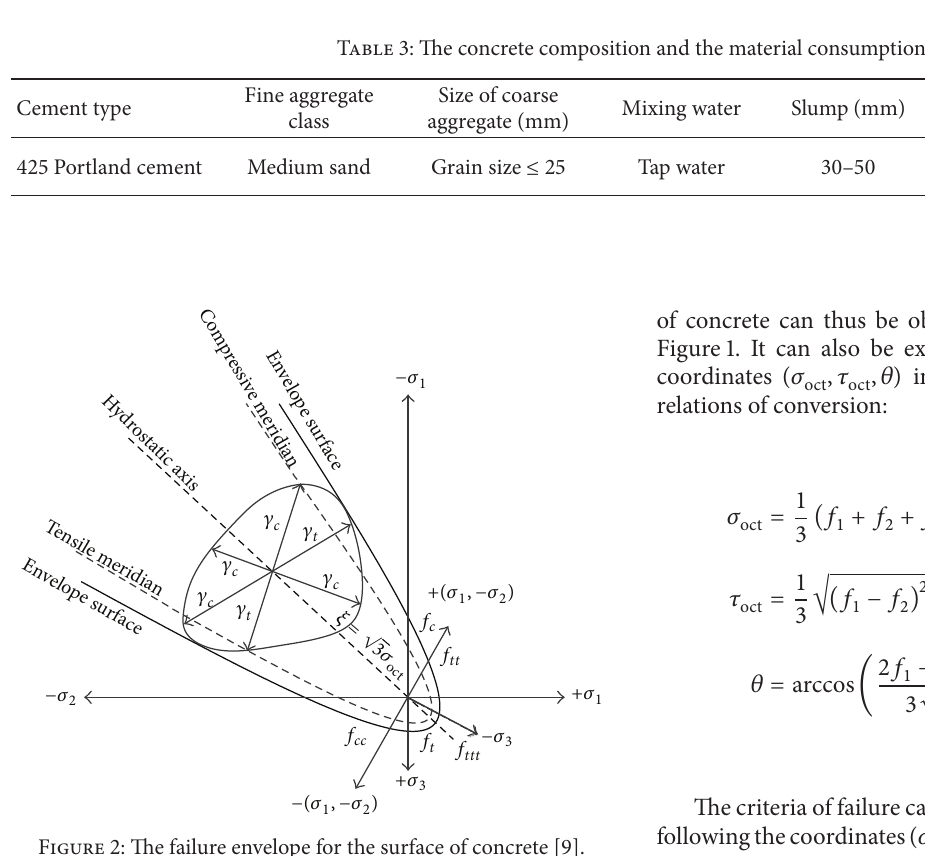
Figure 2: The failure envelope for the surface of concrete